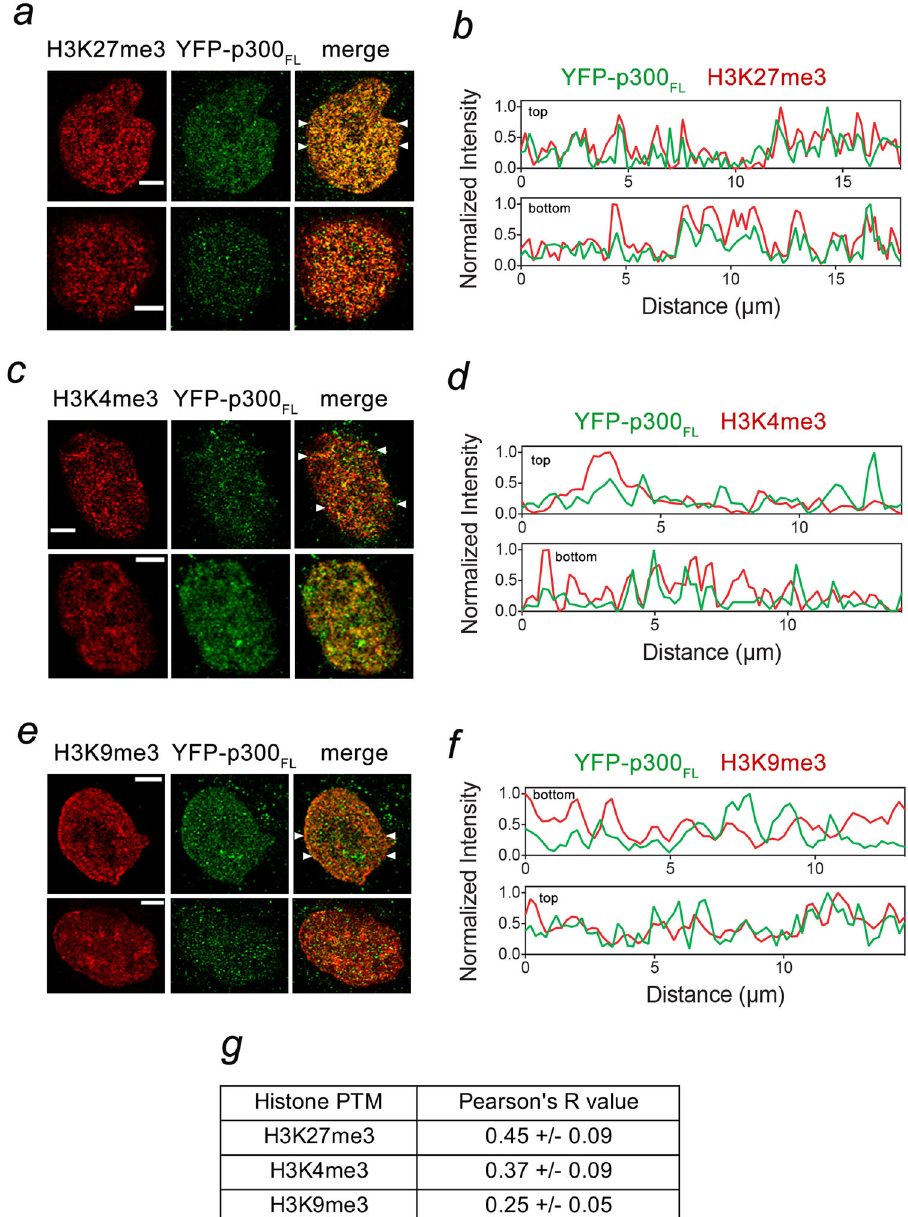
yellow, overlap of fl uorescence signals of YFP-p300 FL and PTMs. The ImageJ software was used to plot fl uorescence signal intensities of YFP-p300 FL and PTMs in the nuclei along the line (from left to right) indicated by white arrowheads ( b , d , f ). Scale bar, 5 µ m. g A table of Pearson ’ s R values calculated using the entire cell nuclei ( n = 3 cells examined for each mark). Data are presented as mean values ± SD. Pearson ’ s R values range between + 1 (perfect positive correlation) and − 1 (inverse